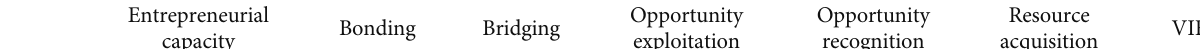
Table 4: Loadings and VIF